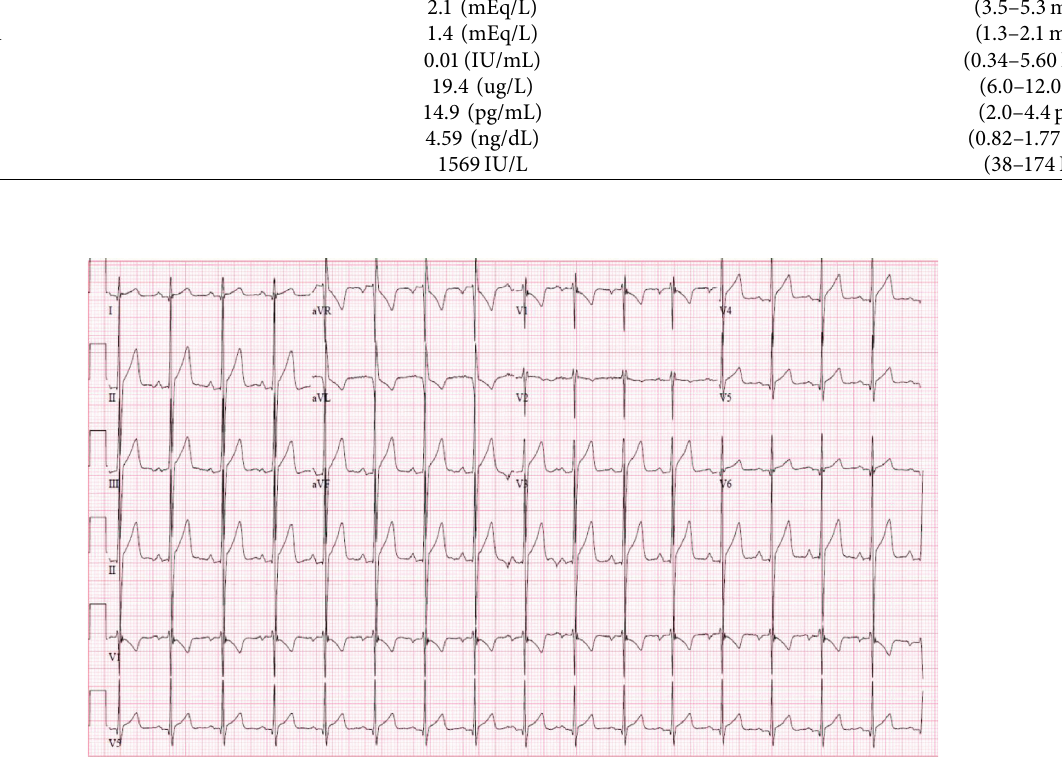
Figure 2: EKG on the second day of